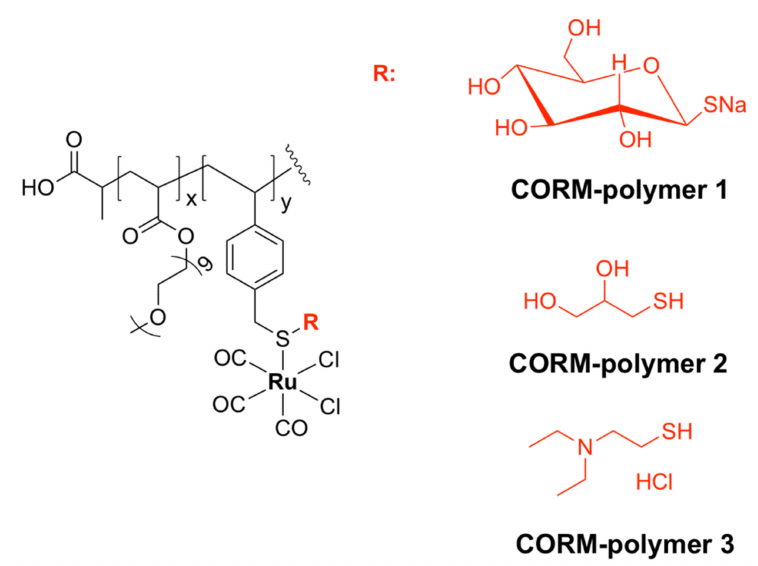
Figure 19. Chemical structures of ruthenium-based CORM-polymers